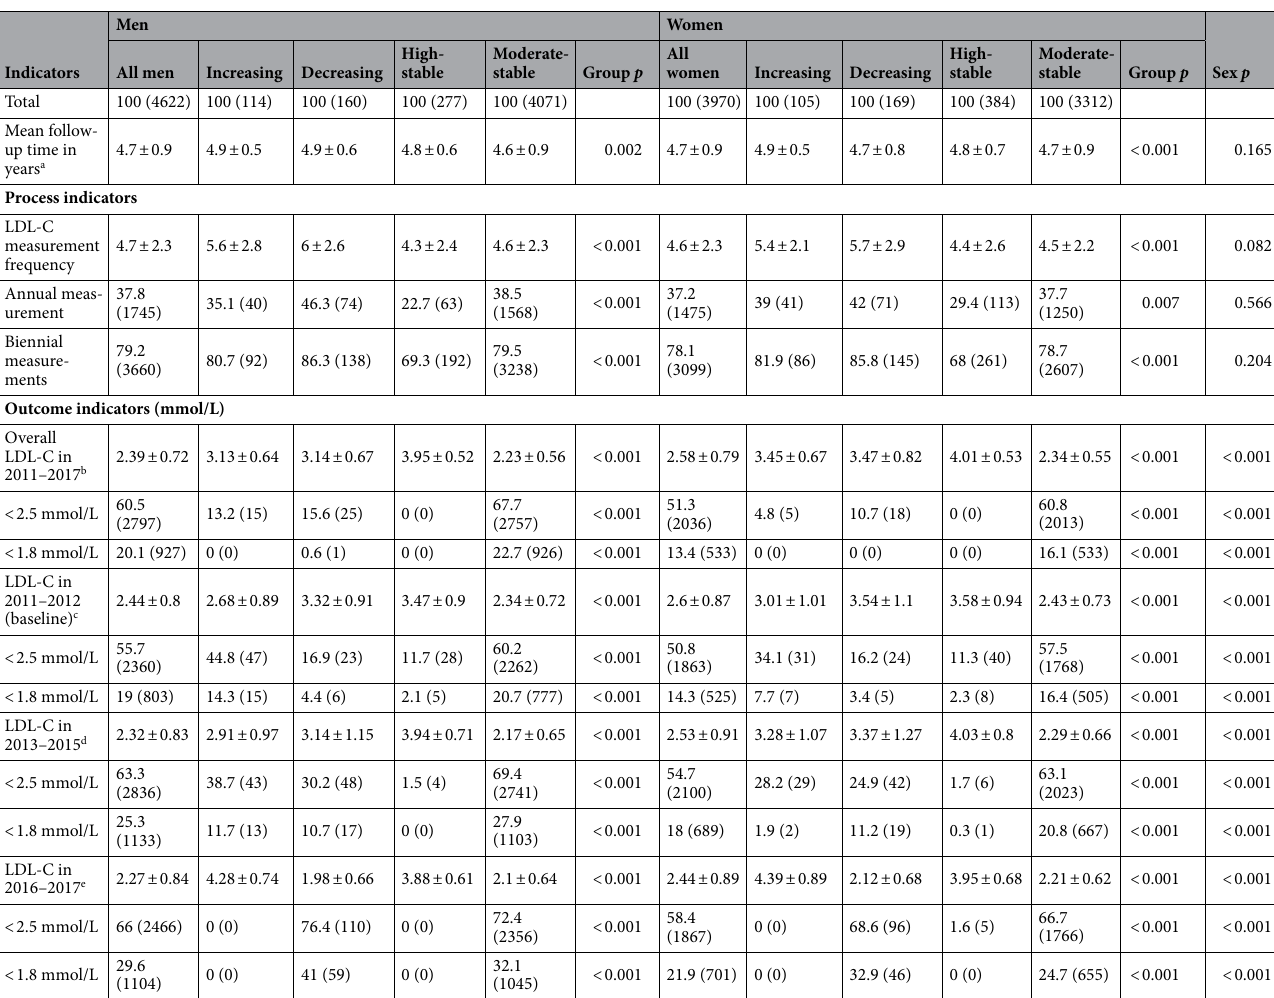
Table 2. LDL-C process and outcome indicators by trajectory group for men and women. Values are expressed as % (n) for categorical variables or mean ± SD for continuous variables. Process indicators based on values during 2013–2017. Outcome indicators based on values during 2011–2017. p value comparisons across trajectory groups and sex are based on χ 2 test for categorical variables and Kruskal-Wallis test for continuous variables. a Mean follow-up time between 1 Jan 2013 and end of follow-up (death, moving out of the region permanently or 31 Dec 2017, whichever came first). b Mean of all valid measurements (2011–2017) starting from the baseline measurement if available. c Number of patients with measurements in 2011–2012 for men (total: 4235, increasing: 105, decreasing: 136, high-stable: 239, moderate-stable: 3755) and women (total: 3667, increasing: 91, decreasing: 148, high-stable: 354, moderate-stable: 3074). d Number of patients with measurements in 2013–2015 for men (total: 4479, increasing: 111, decreasing: 159, high-stable: 260, moderate- stable: 3949) and women (total: 3838, increasing: 103, decreasing: 169, high-stable: 360, moderate-stable: 3206). e Number of patients with measurements in 2016–2017 for men (total: 3735, increasing: 106, decreasing: 144, high-stable: 230, moderate-stable: 3255) and women (total: 3196, increasing: 98, decreasing: 140, high- stable: 310, moderate-stable: